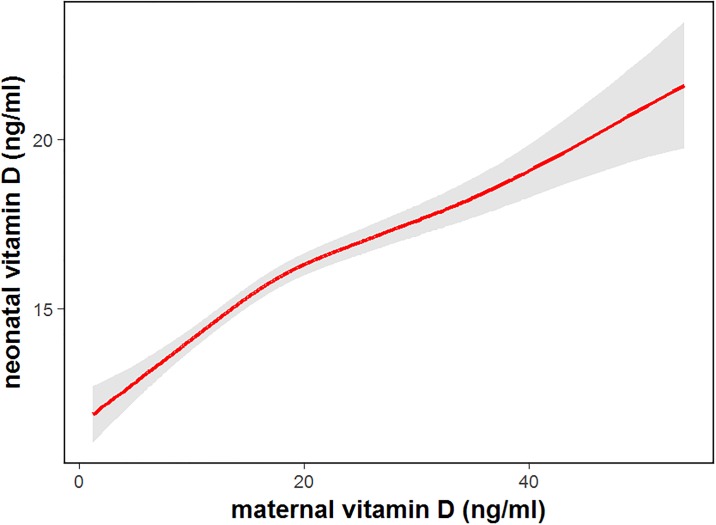
Neonatal cord blood 25(OH)D level was predicted by maternal 25(OH)D level modeled by restricted cubic splines.The solid line is the predicted cord blood level, the gray shading is 95% confidence intervals.